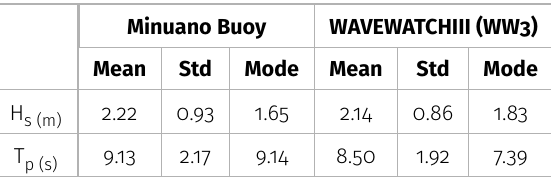
Table I. Basic descriptive statistical parameters for the Minuano buoy and WW3.